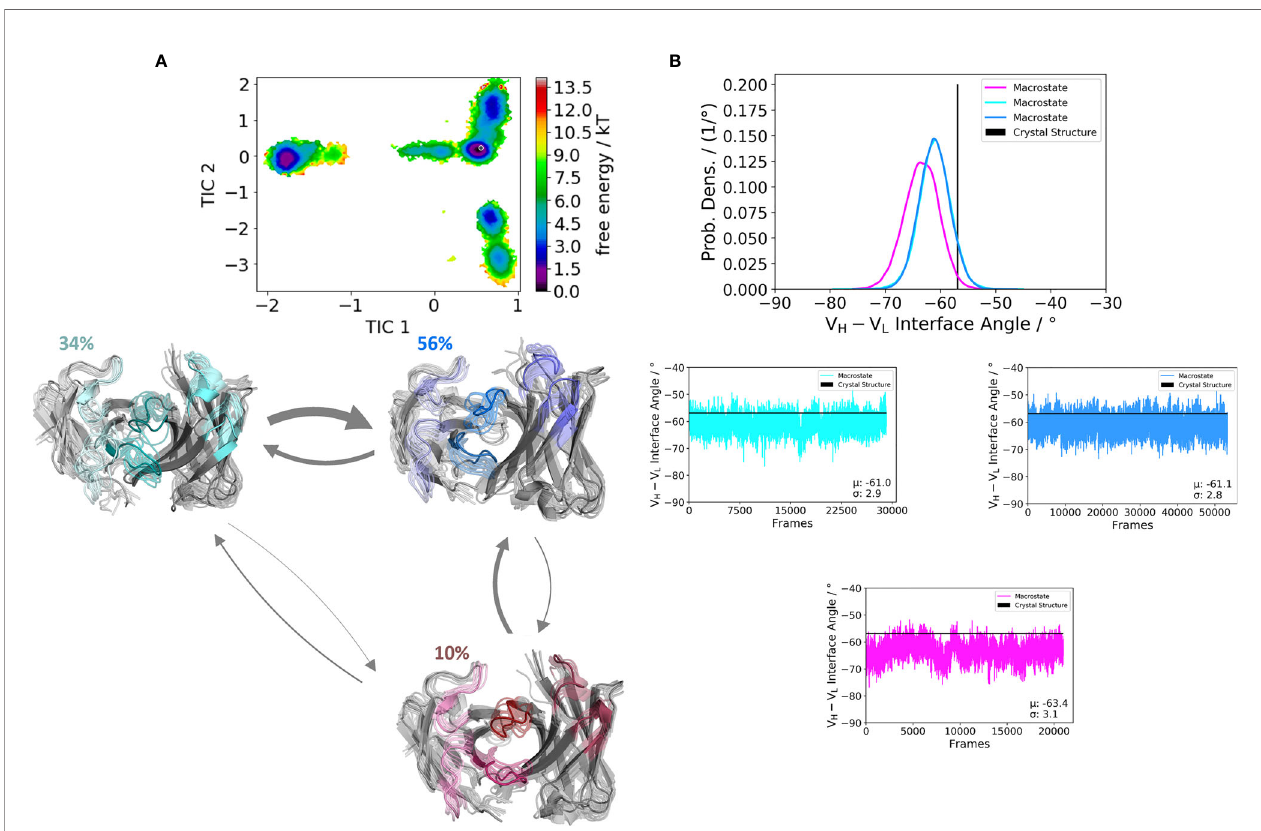
FIGURE 4 | Germline pairing speci fi c paratope states in solution for the H5-51:L1-39 (4KMT) Fabs. (A) Illustrates the paratope states, free energy surface, macrostate ensemble and the respective V H and V L orientations for the 4KMT antibody. (B) We observe shifts in the V H and V L orientations upon rearrangements in the paratope, which are visualized as probability density distributions. The starting X-ray structure for the underlying simulations is depicted as black dot in the free energy surfaces and as black line in the plots showing the V H -V L angle